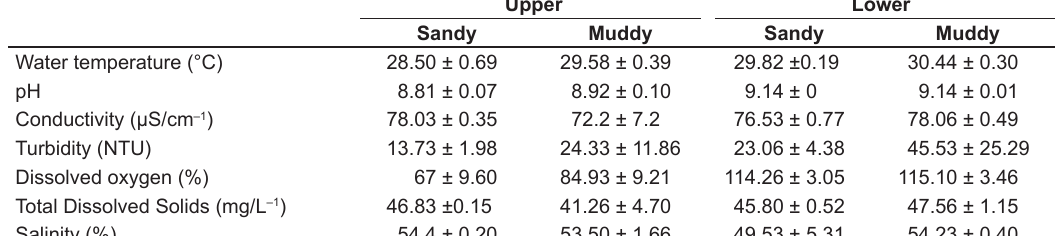
Table 1. Environmental variables (mean and standard deviation) measured at the upper and lower area of the Tubarão River, State of Rio Grande do Norte, Northeastern Brazil. Upper Lower Sandy